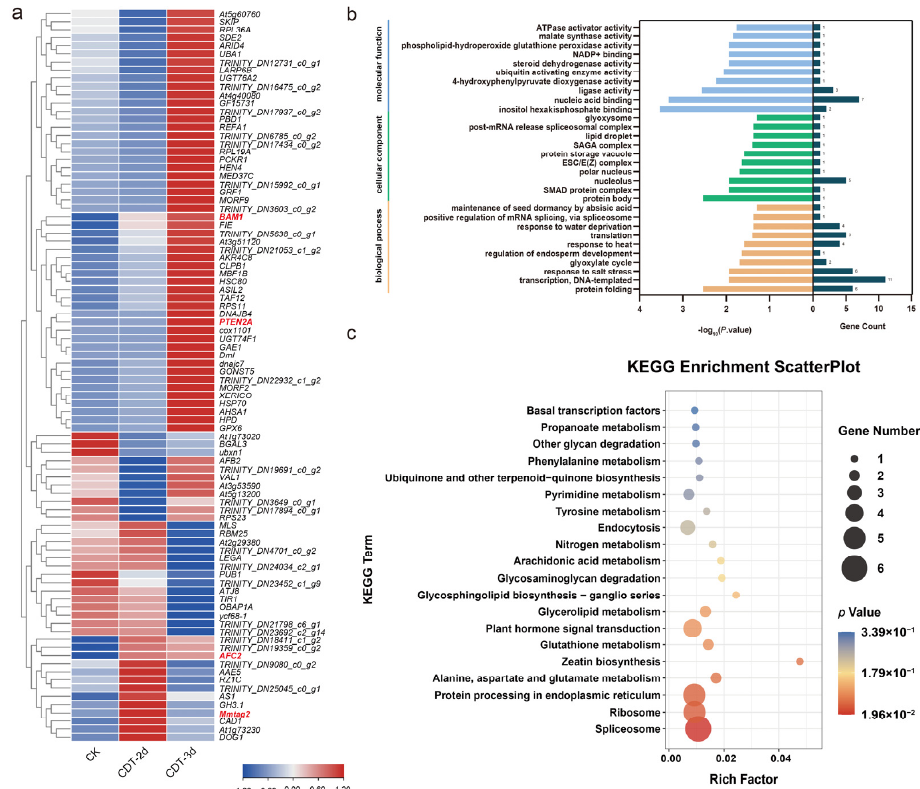
Figure 4. Overview of identified target genes of DEMs by degradome sequencing. ( a ) Expression profile of target genes of DEMs. CK, control check; CDT − 2d, seeds aged for two days; CDT − 3d, seeds aged for three days. The genes further analyzed by experimental approaches are highlighted in red. The blue − red bar at the bottom right of the heat map indicates the relative expression intensities. The darker the red color, the higher the expression, while the darker the blue color, the lower the expression. The expression pattern diagrams of miRNAs were plotted using TBtools v1.108. ( b ) The top 10 GO terms with the lowest p value were enriched for mapping. The ordinate is the GO entry, the left abscissa is the − log 10 p value of the enrichment analysis, and the right abscissa is the gene number. ( c ) KEGG enrichment analysis for target genes of DEMs.